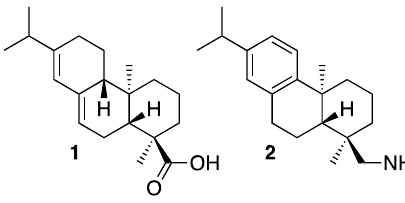
Figure 1. Abietic acid ( 1 ) and (+)-dehydroabietylamine ( 2 ).